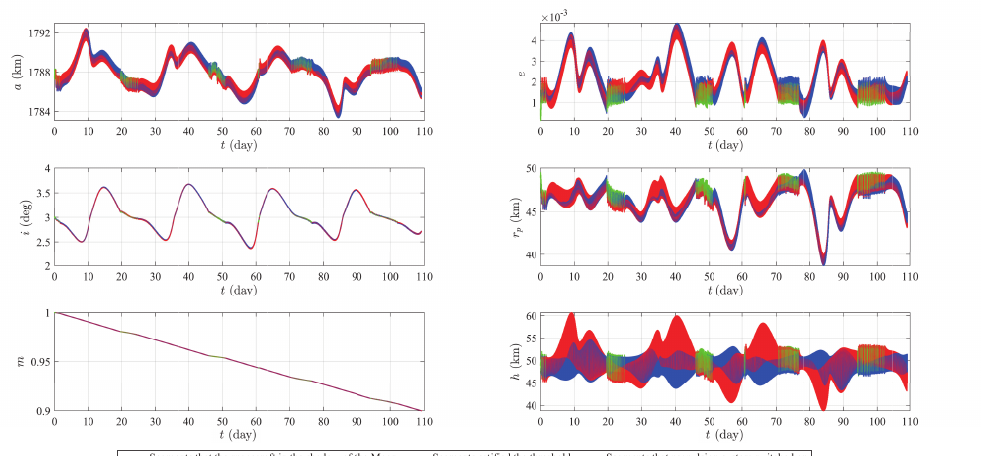
Figure 4. The variation of orbit elements during orbit maintenance with thrust (cid:107) T (cid:107) = 20 mN, Ω = 240 ◦ and i = 3 ◦